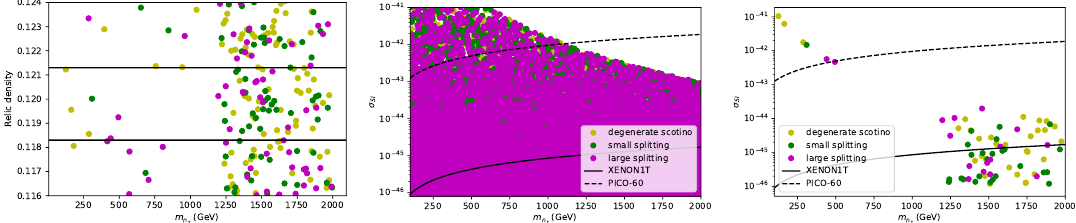
Figure 3 . (Left): relic density vs. m n with horizontal black lines showing 1 σ range Ω obs h 2 . DM τ (Middle): direct detection cross section against m n , along with bounds from XENON1T (in black τ solid) and PICO experiments (in black dashed). (Right): direct detection cross section against m n , with points satisfied by Ω obs within 1 σ . Different colours correspond to different scotino mass τ hierarchy with Case (i) — degenerate scotino mass scenario (greenish yellow), Case (ii) — small mass splitting (green) and Case (iii) — large mass splitting (magenta) given in table